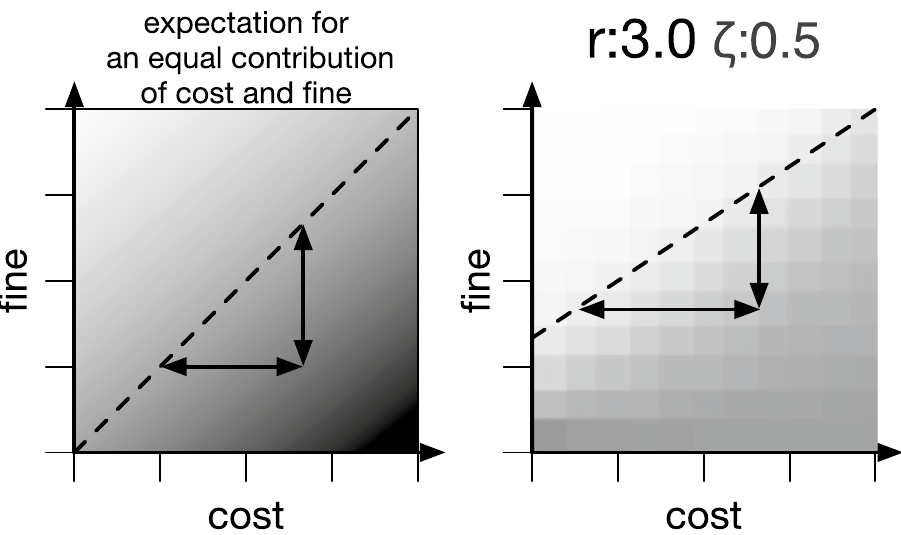
Figure 4. Illustration how fine β and cost γ affect the critical point differently. When expecting an equal contribution (left panel) changing either cost or fine should be proportional with respect to the change of the critical point (arrows in the left panel are equal), the critical point is illustrated as a dashed line. However, the model results (and the predictions from Eq. 6) suggest a different behavior (right panel for r = 3.0 and ζ = 0.5 ): changes in cost γ must be much larger than changes to fine β in order to achieve the same effect on the critical point—illustrated as a dashed